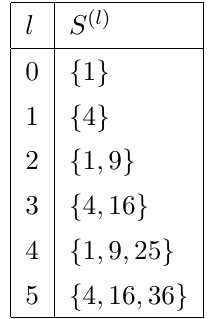
Table 2 . The set S ( l ) for l ∈ { 0 , 1 , 2 , 3 , 4 , 5 }